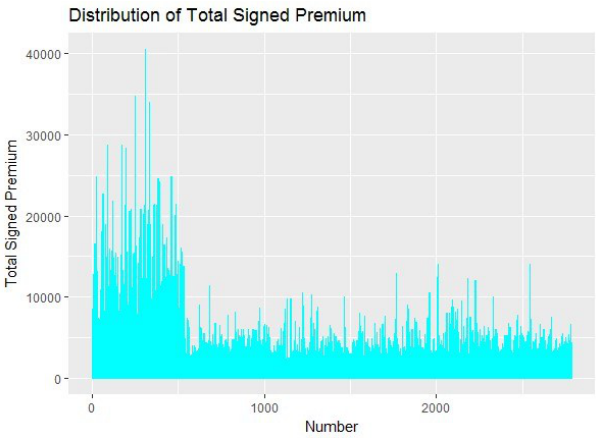
Figure 1. Distribution of the total signed premium.